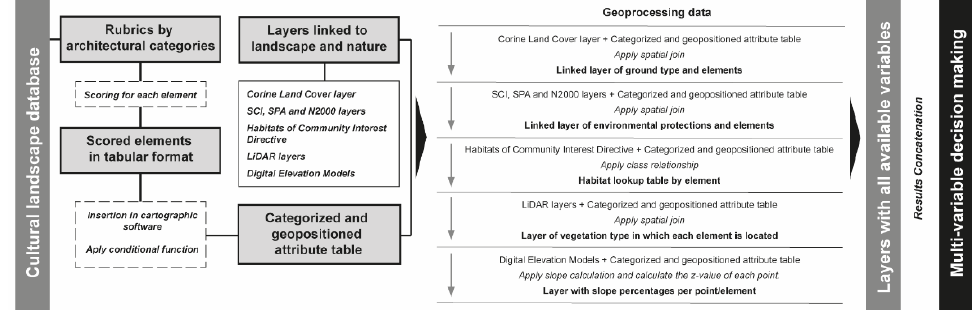
Figure 3. Description of the geoprocesses used in the methodology of the study.